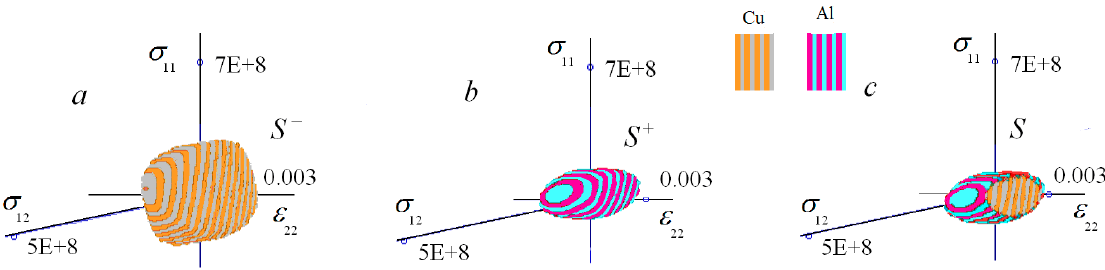
Figure 11. Failure surfaces: ( a ) for the left (copper) and ( c ) the right (aluminum) sides of the weld separately; ( b ) for the weld as a whole, ( a , b ) S − and S +